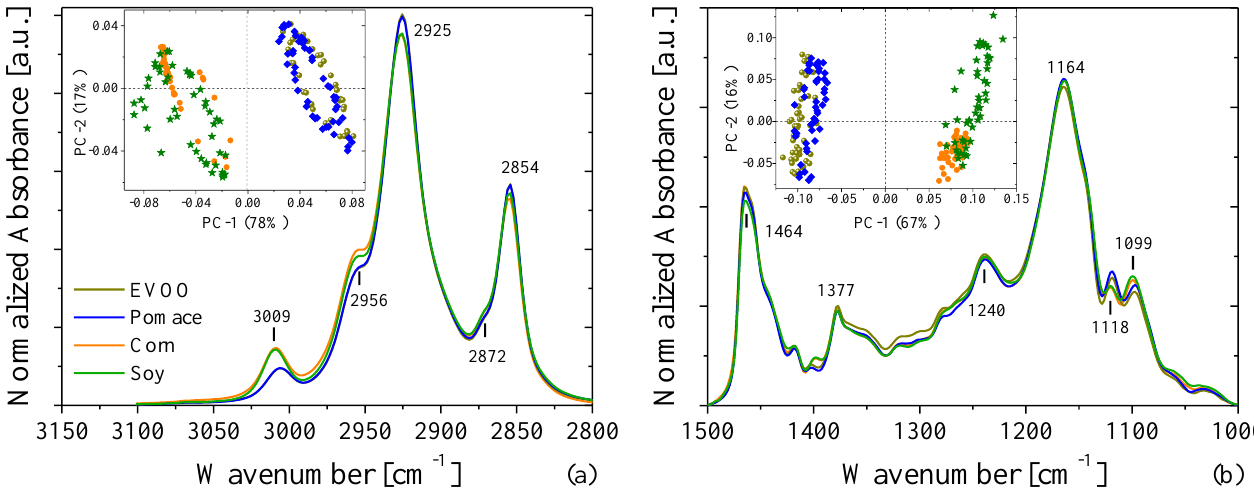
Figure 4. FTIR spectra of four oils: EVOO (pale green), olive-pomace (blue), corn (orange) and soy (dark green) over two different wavenumber ranges focusing on the ( a ) hydrogen stretching functional groups and ( b ) CH i (i = 1, 2, 3) functional groups present in each oil.